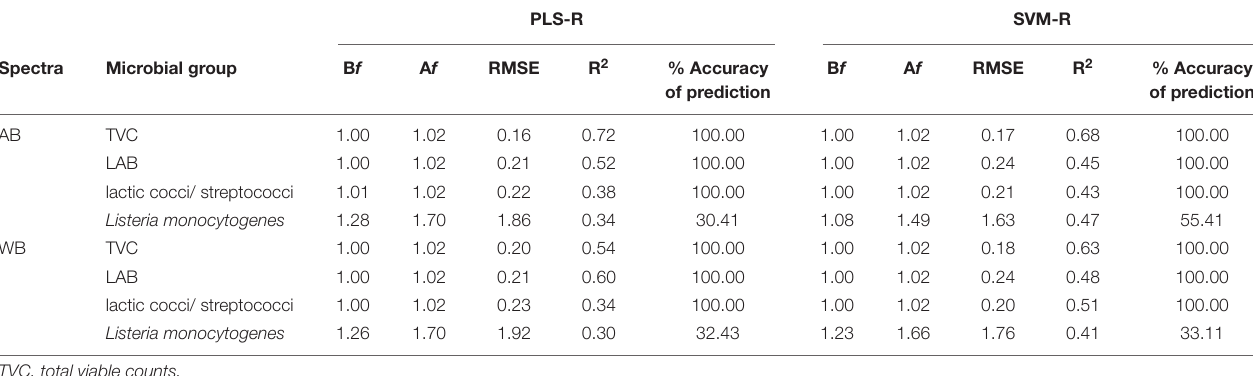
TABLE 1 | Comparison of calculated performance indices for prediction of microbial groups in yogurt samples using predicted estimates of external validation dataset from partial least squares—regression (PLS-R) and support vector machines—regression (SVM-R) models based on FTIR spectral data [air background (AB) and water background (WB)].